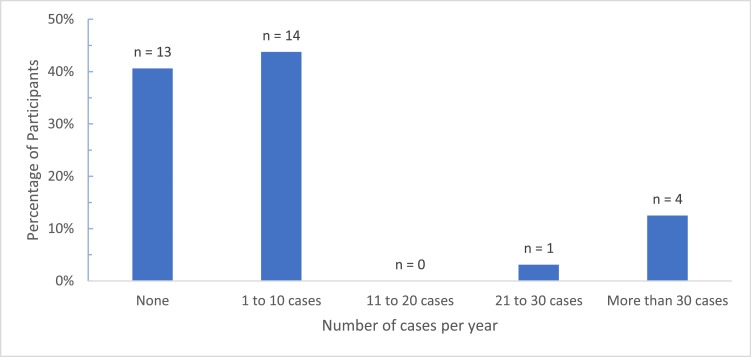
Number of Reconstructive Microsurgical Procedures Performed (5-Year Experience).